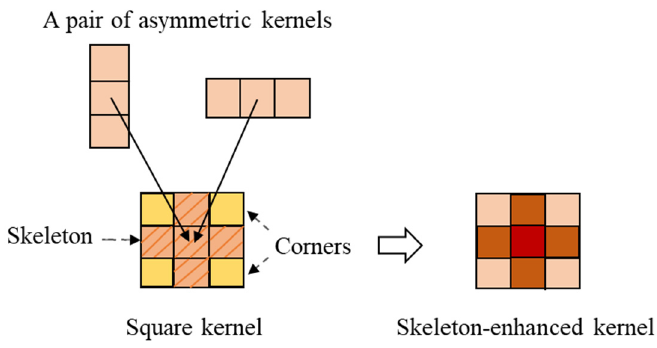
Figure 4. The structure of the skeleton-enhanced kernel.